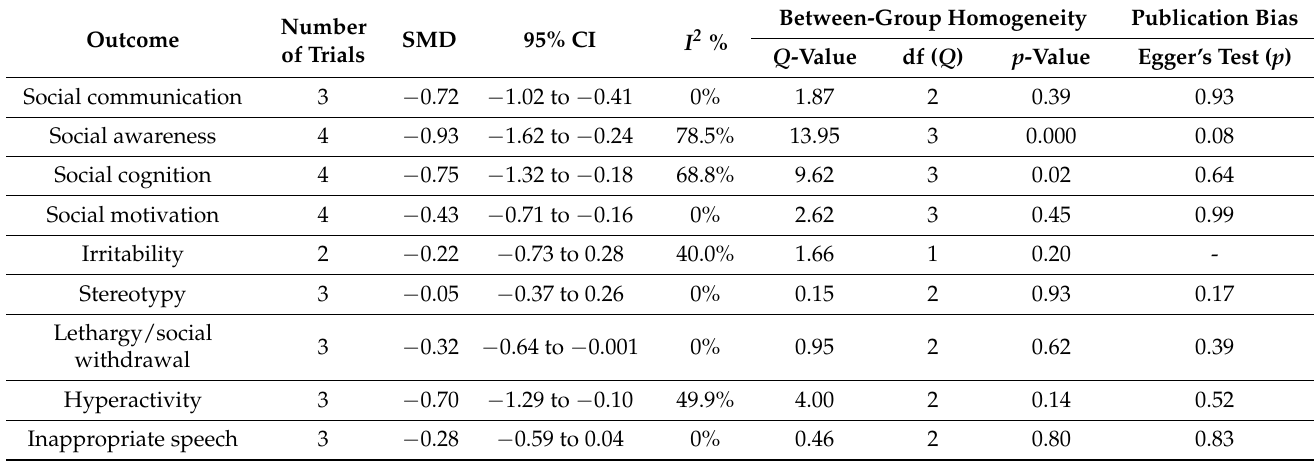
Table 3. Meta-analysis results for the effects of horse-assisted therapy vs. control intervention.